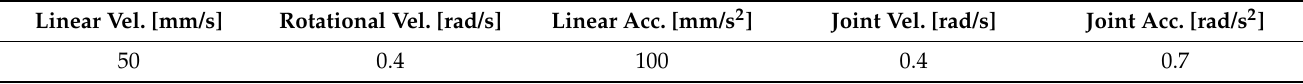
Table 4. Motion Parameters for the UR-5 teleoperation (vel. = velocity, acc. = acceleration). Linear Vel. [mm/s]